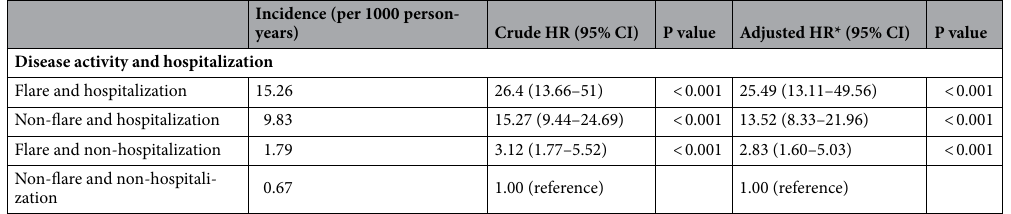
Table 5. Risk of venous thromboembolism by disease activity and hospitalization in IBD cohort. IBD inflammatory bowel disease; HR hazard ratio; CI confidence interval. *Adjustment for age, sex, provoking factors (recent surgery, fracture, and pregnancy within 90 days of event), and co-morbidities.